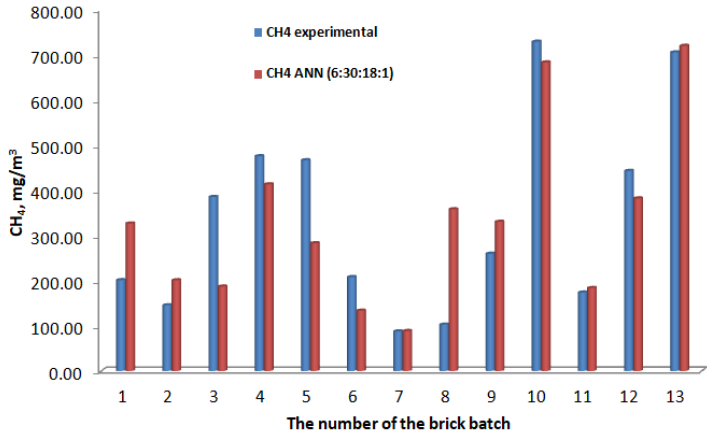
Figure 3. Experimental values for CH 4 compared to those obtained with the ANN (6:30:18:1)